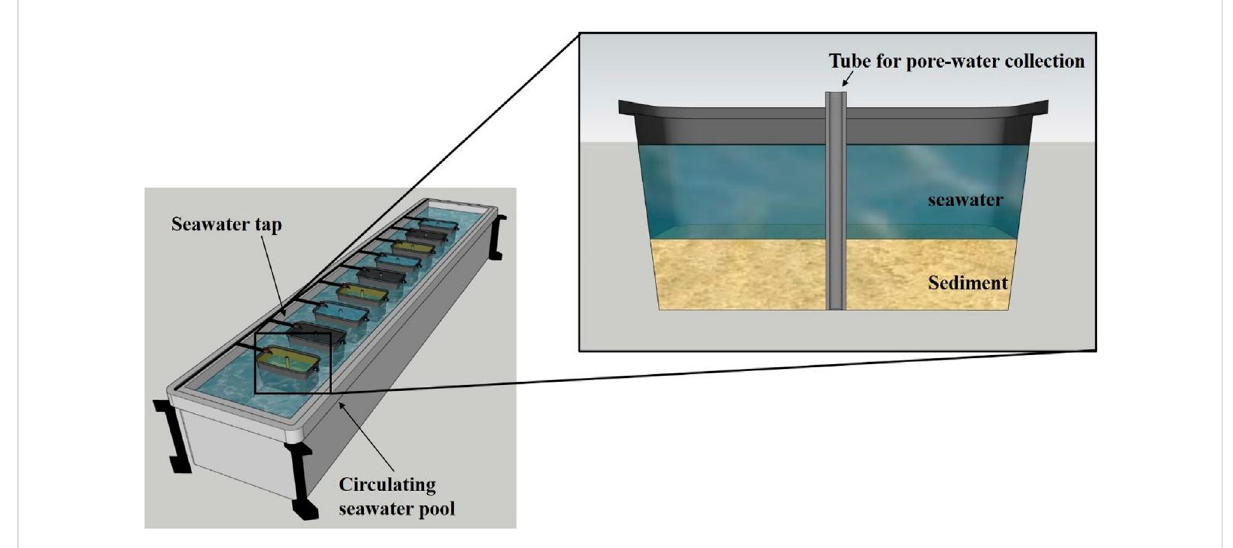
FIGURE 1 Illustration showing the benthocosm experimental design used in this study. Each benthocosm was fi lled with surface sediment (20 cm) and overlying water (25 cm) collected from the littoral zone of the southeastern Mediterranean Sea in February 2019. Crude oil or gas condensate were added to the overlying water, mimicking a moderate pollution scenario ( < 500 µm thick layer). Three benthocosms remained unamended (hydrocarbons were not added). The porewater and top sediment were sampled every 7 – 14 days for 6 months ( n = 17 sampling